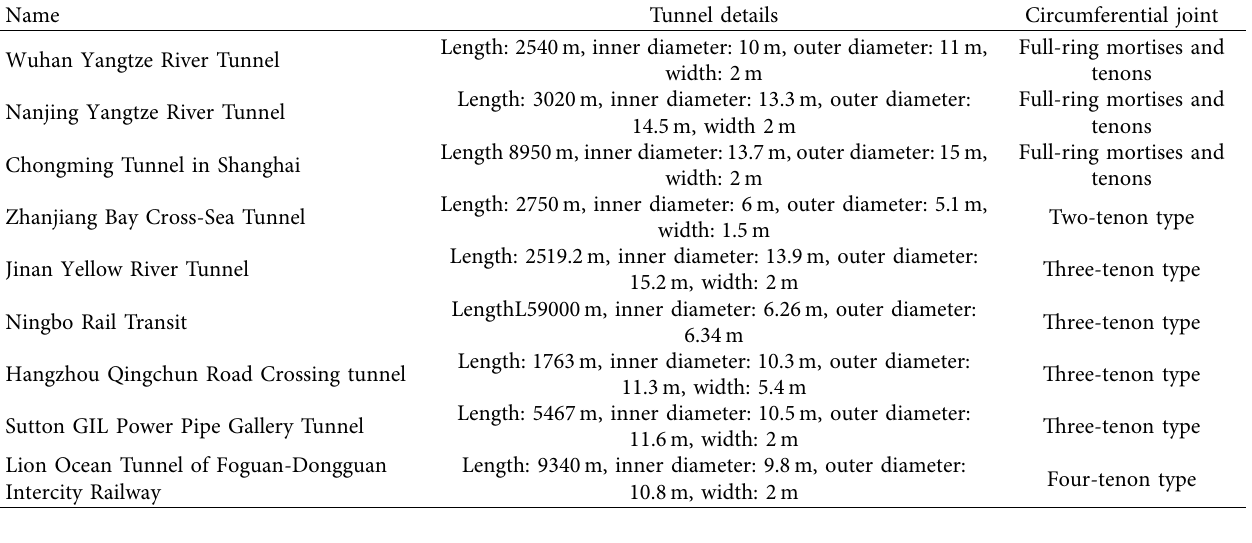
Table 1: List of domestic representative joint structures of shield tunnels.